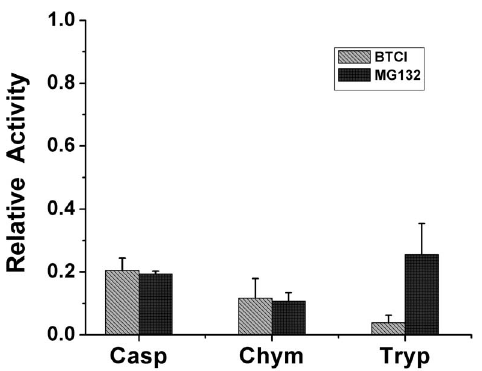
Figure 5. Inhibitory activity of BTCI and MG132 (positive control), toward 20S proteasome caspase-like (Casp), chymo- trypsin-like (Chym) and trypsin-like (Tryp). The concentration of both inhibitors is 10 m M. As shown, BTCI is a more potent inhibitor for trypsin than MG132 and presented similar inhibition to MG132 against caspase-like and